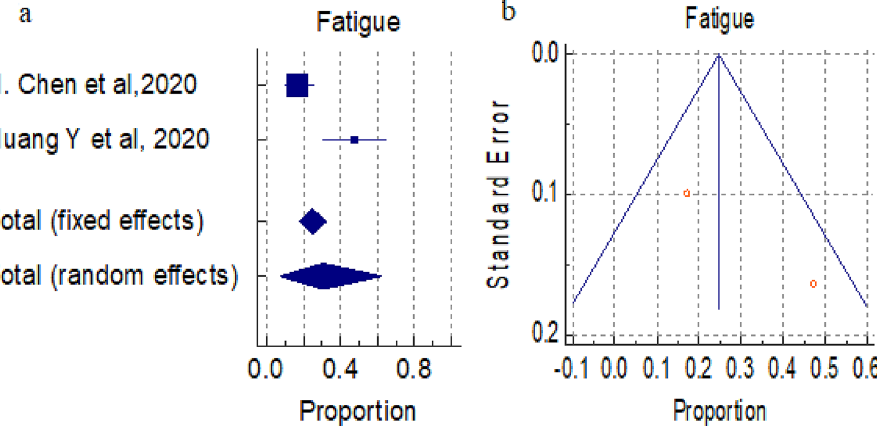
Figure 7. ( a ) Forest plot showed pooled prevalence of Fatigue among patients with COVID-19. ( b ) Funnel plot showed publication bias among studies evaluating neurological complications of COVID-19.